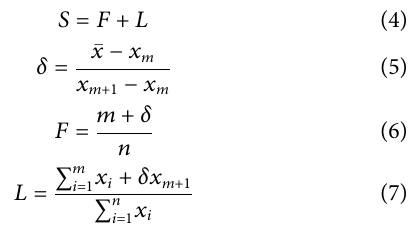
Frontiers in Environmental Science |